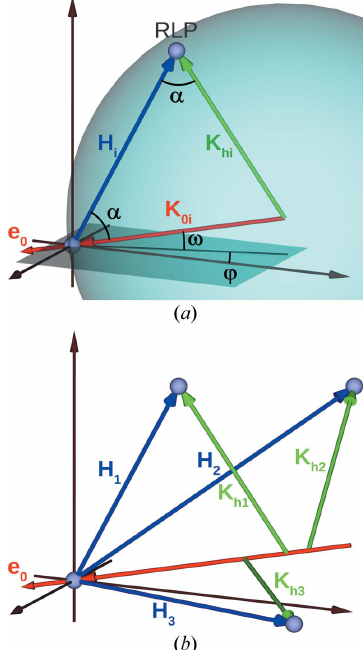
Figure 3 Diffraction in reciprocal space: ( a ) at a single RLP with the reciprocal vector H i . The incident beam K 0 i along the unit vector e 0 and the length of the diffracted beam is | K hi | = | K 0 i | = K i , where K i is the radius of the Ewald sphere (blue) intersecting the excited RLP; ( b ) three different RLPs excited at different energies while the incident beam direction is kept constant (along the unit vector e 0